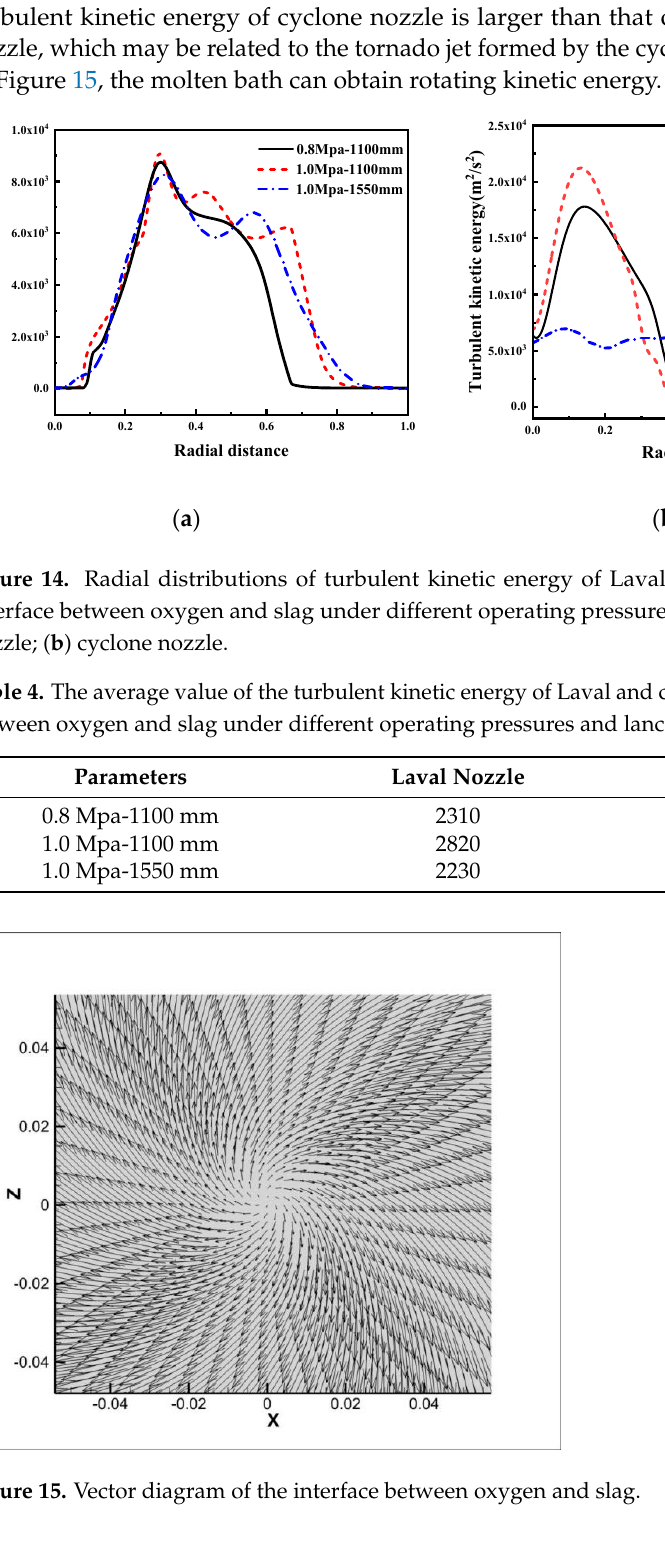
Figure 13. Axial distributions of turbulent kinetic energy and turbulent dissipation rate of cyclone